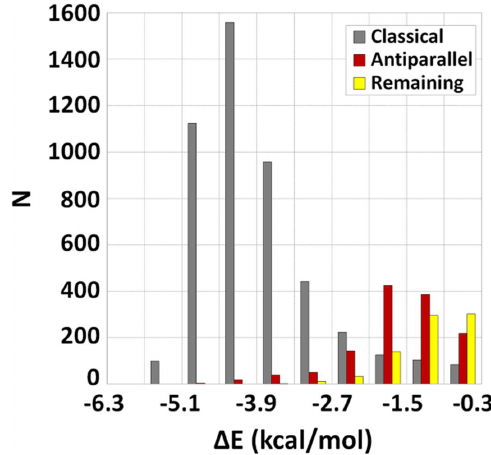
Figure 5 Distribution of interaction energies of attractive water–water contacts found in the CSD after applying the criteria for classical hydrogen bonds ( d OH (cid:2) 3.0 A˚ and (cid:2) (cid:3) 120 (cid:4) ) and antiparallel interactions ( (cid:3) 1 , (cid:3) 2 (cid:3) 160 (cid:4) , 80 (cid:2) (cid:2) (cid:2) 140 (cid:4) and T HOHO > 40 (cid:4) ), calculated at the CCSD(T)/CBS level of